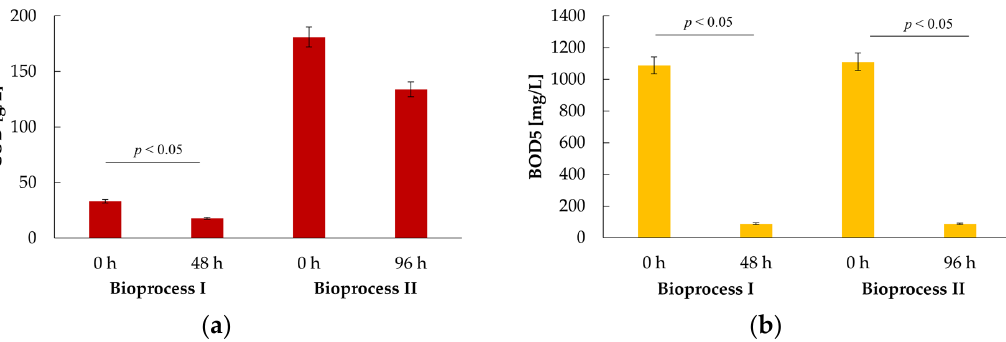
Figure 8. Whey permeate organic load reduction during 48 h cultures of K. marxianus WUT240 in 25WP (Bioprocess I) and 96 h cultures in 200 WP (Bioprocess II). The environmental impact of whey permeate was measured at the beginning (0 h) and the end of the cultures (of digestive liquids after main products extraction) as ( a ) COD and ( b ) BOD5 parameters.